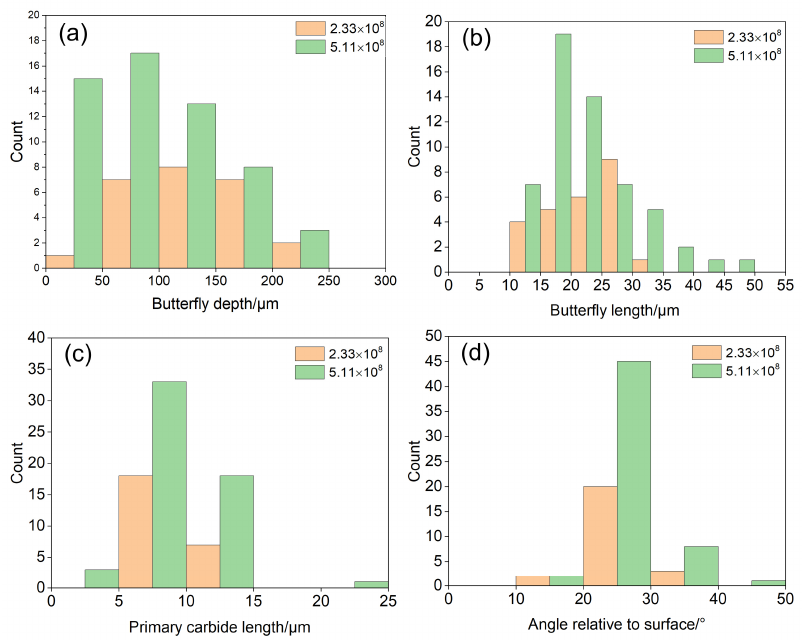
Figure 3. Characteristics of the butterflies in RCF samples tested under 4 GPa: ( a ) frequency histogram of the depth of the butterflies from the surface; ( b ) frequency histogram of the length of the butterflies; ( c ) frequency histogram of the length of the primary carbides associated with the butterflies; ( d ) frequency histogram of the angle.